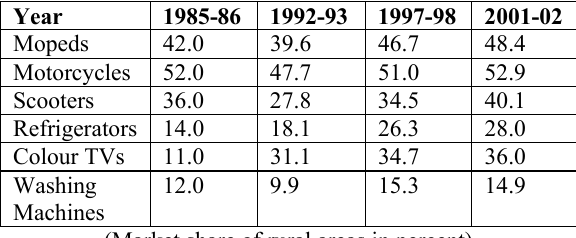
Table 2: Rural Demand is Key to Several Industries’